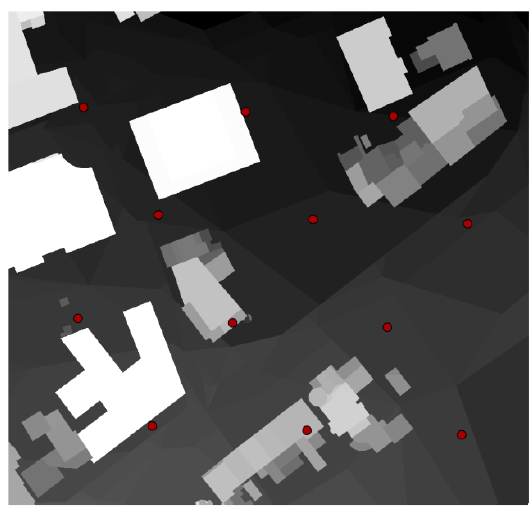
Figure 9. The initial positions of sensors based on a triangular